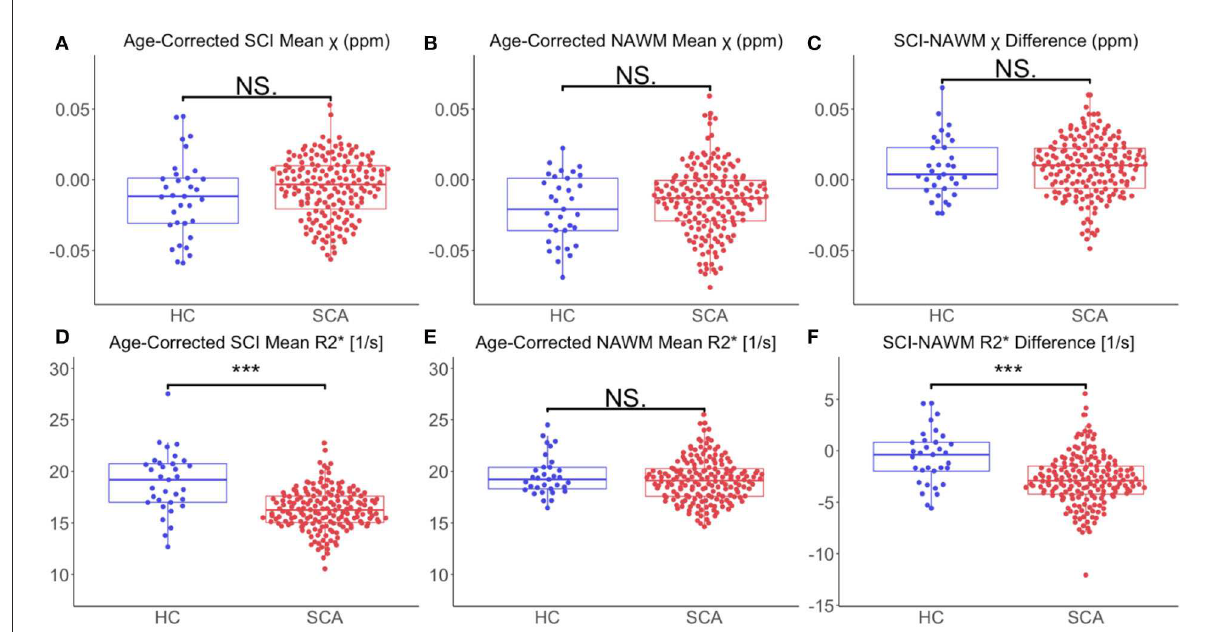
FIGURE6 Effect of SCA on SCI and NAWM χ and R * 2 . (A) Comparison of mean age-corrected silent cerebral infarct (SCI) susceptibility ( χ ) in patients with sickle cell anemia (SCA) and healthy controls (HC). (B) Comparison of mean age-corrected normal appearing white matter (NAWM) χ in SCA and HC. (C) No significant differences in mean SCI-NAWM χ difference were observed between the SCA and HC groups (0.009 vs. 0.006 ppm, p * = 0.5). (D) Comparison of mean age-corrected SCI R * 2 in SCA and HC. (E) Comparison of mean age-corrected NAWM R 2 in SCA and HC. (F) The SCI–NAWM R * 2 difference was significantly lower in patients with SCA relative to HC (– 2.84 vs. – 0.64 s − 1 , p < 0.0001). SCI were segmented using the FLAIR-based SIT trial definition. *** p <